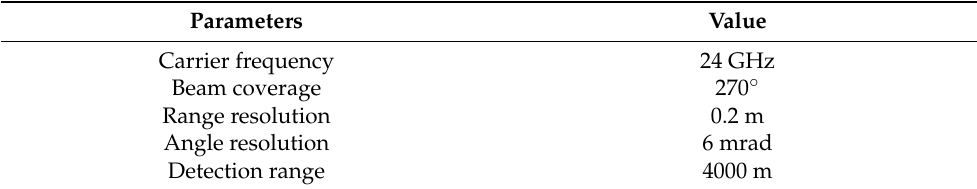
Figure 1. Main mine of Dabao Mountain Mine, the Arc-SAR system and its location: ( a ) main mine and the Arc-SAR system, ( b ) location of the Arc-SAR system. Table 1. System parameters of the Arc-SAR